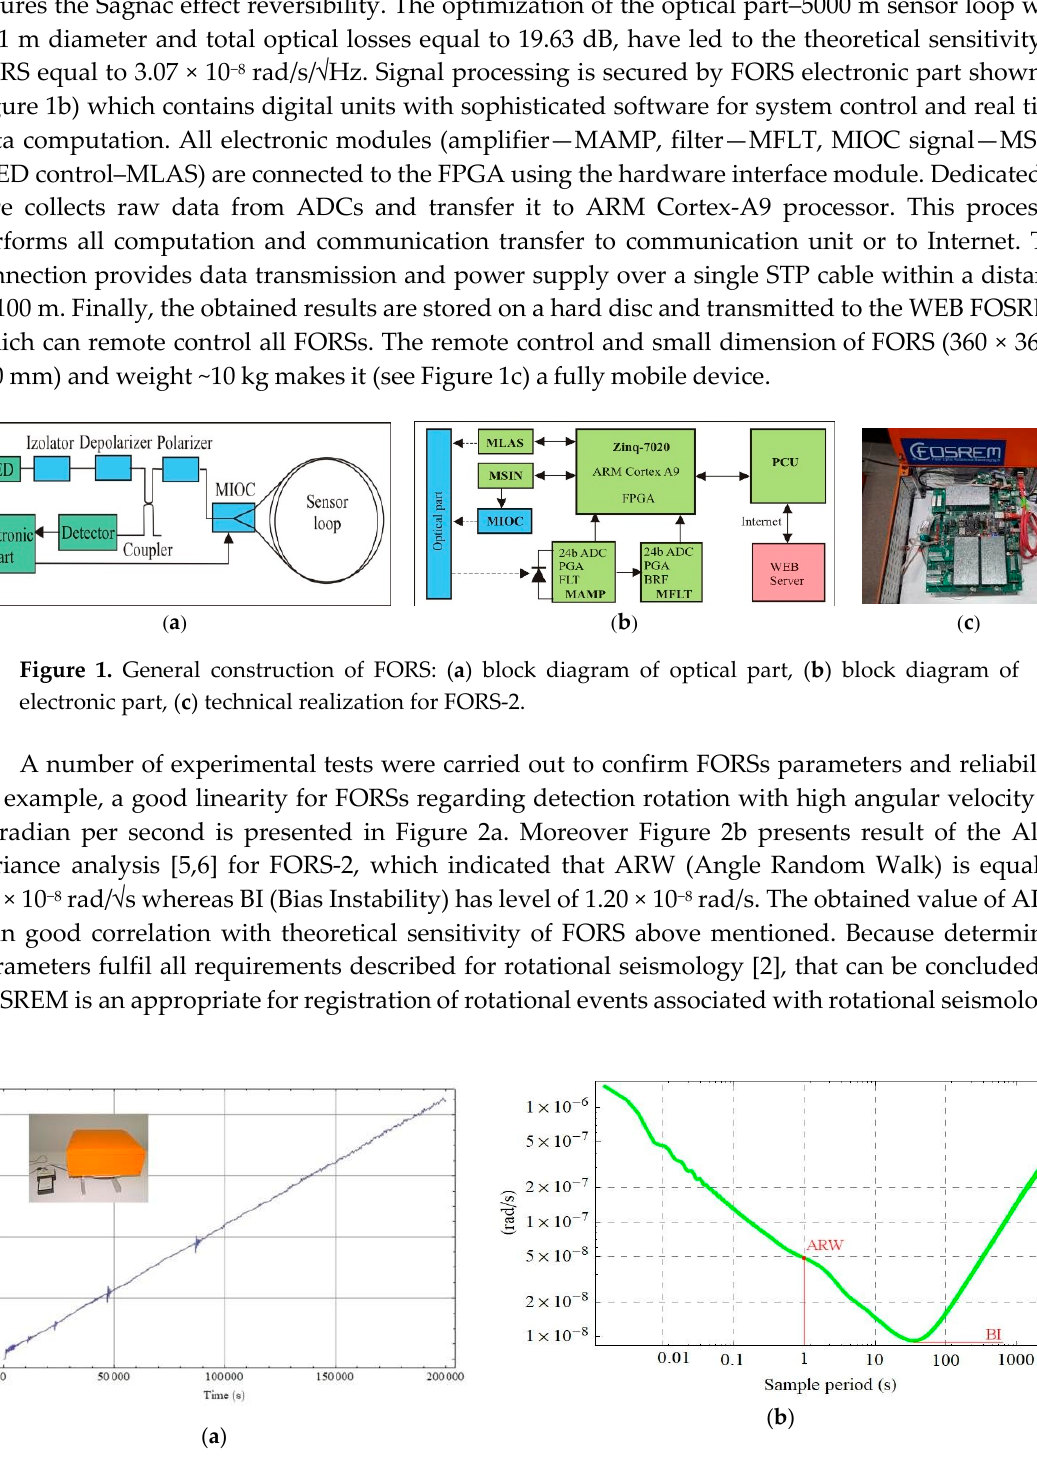
Figure 2. Results of FORS-2 laboratory investigation: ( a ) recording rotational speed with increasing angular velocity up to 0.9 rad/s, ( b ) the Allan variance